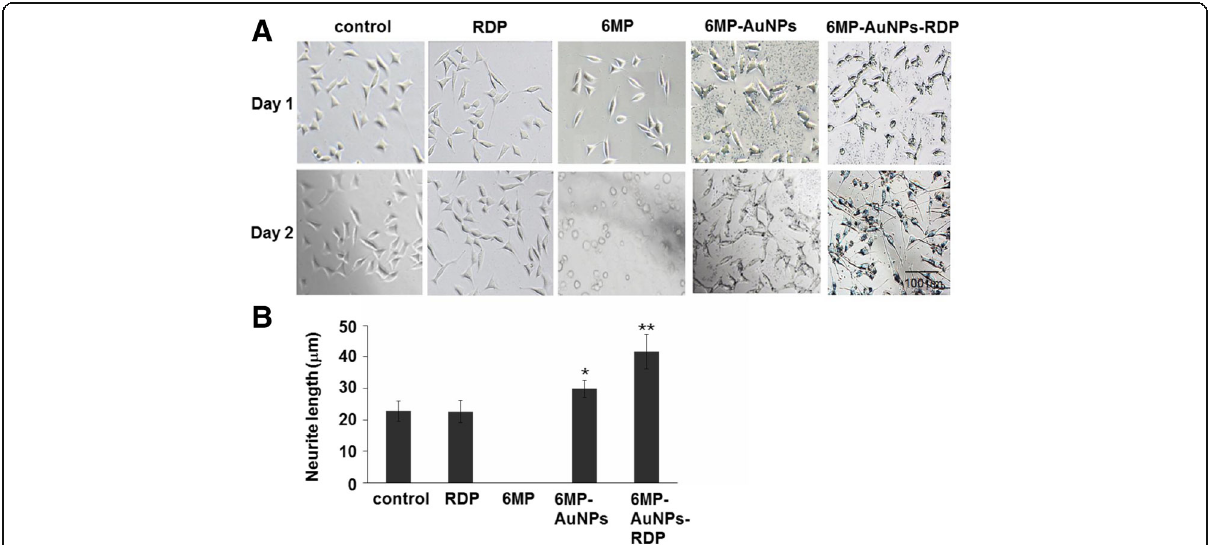
Fig. 5 The nanoparticles promoted neurite growth. Images ( a ) and neurite length ( b ) after the cells were respectively treated with RDP, 6MP-AuNPs, and 6MP-AuNPs-RDP for 24 h. The cells with only solvent were used as control. The values were averaged for 200 neurites. * p <0.05 and ** p <0.01 compared with the